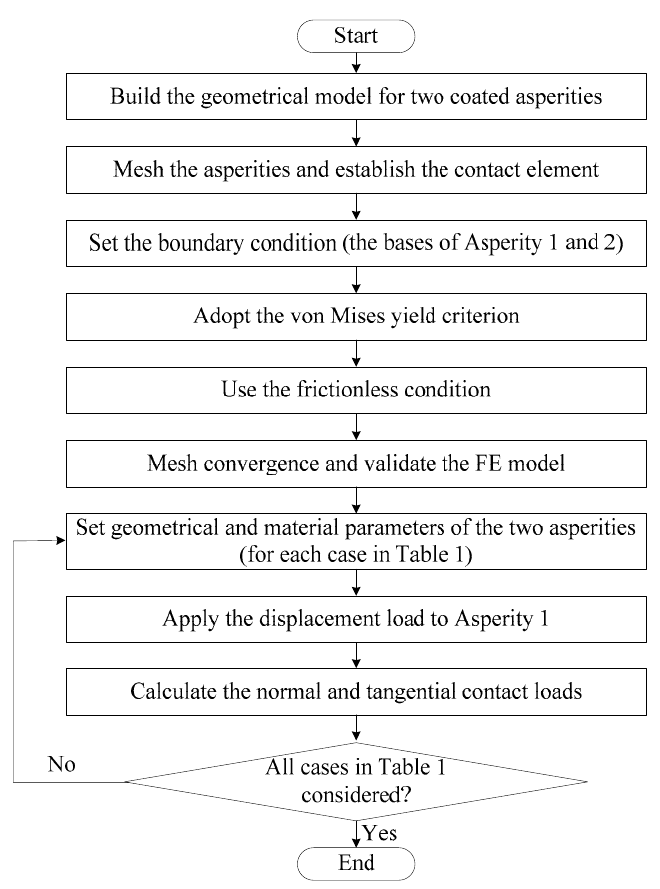
Figure 4. The flowchart showing the details of the development of the FE model.